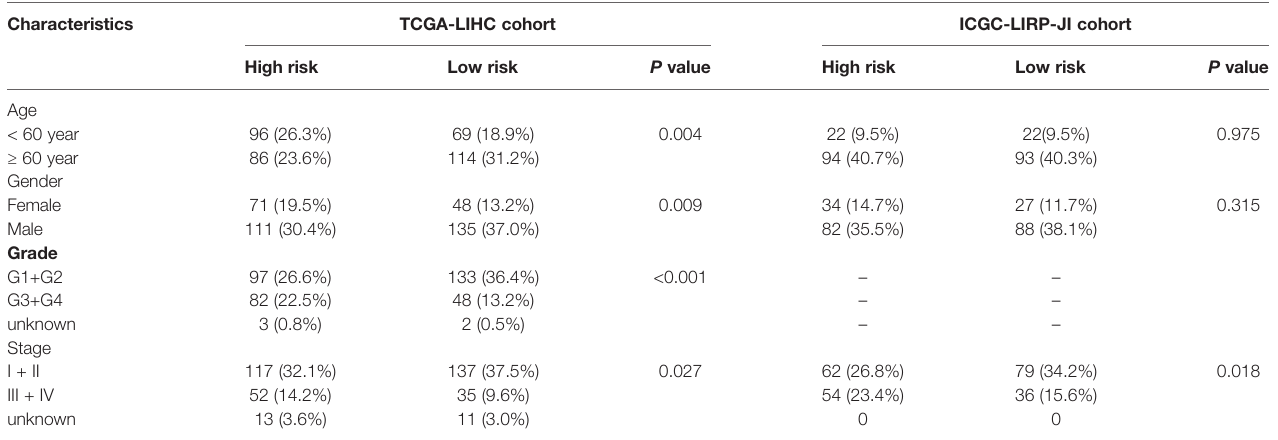
TABLE 2 | Baseline characteristics of the patients in different risk